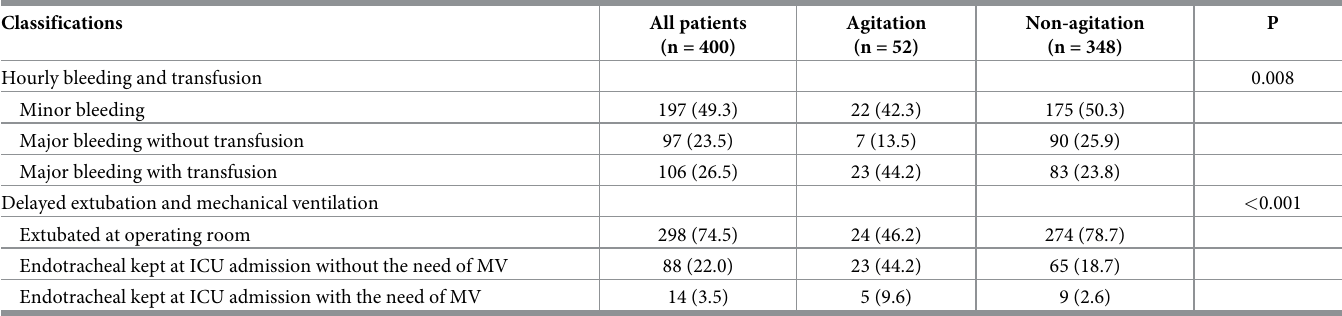
Table 4. Covariate classifications used for in the multivariate model building.